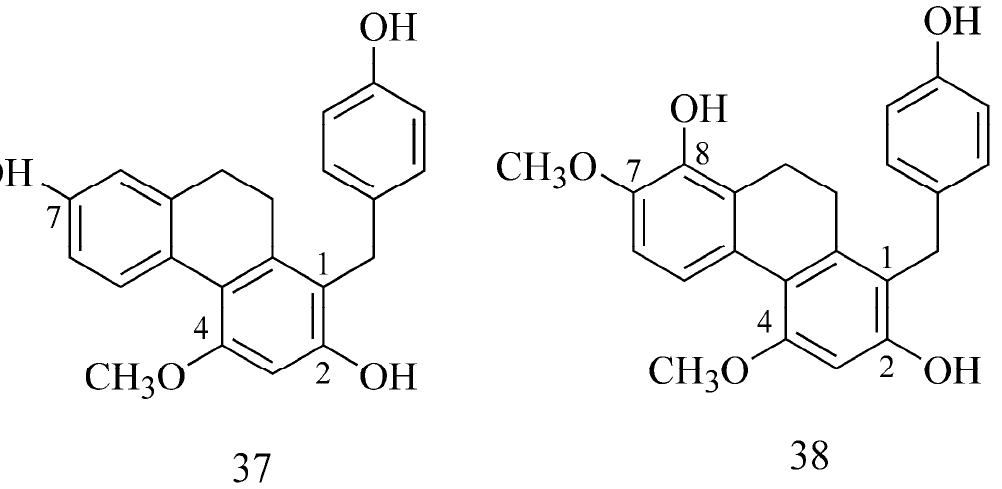
Figure 13. Chemical structures of 1-[(4-hydroxyphenyl)methyl]-4-methoxy-2,7-phenanthrenediol ( 37 ) and 1-(4-hydroxybenzyl)-4, 7-dimethoxyphenanthrene-2,8-diol ( 38 ).